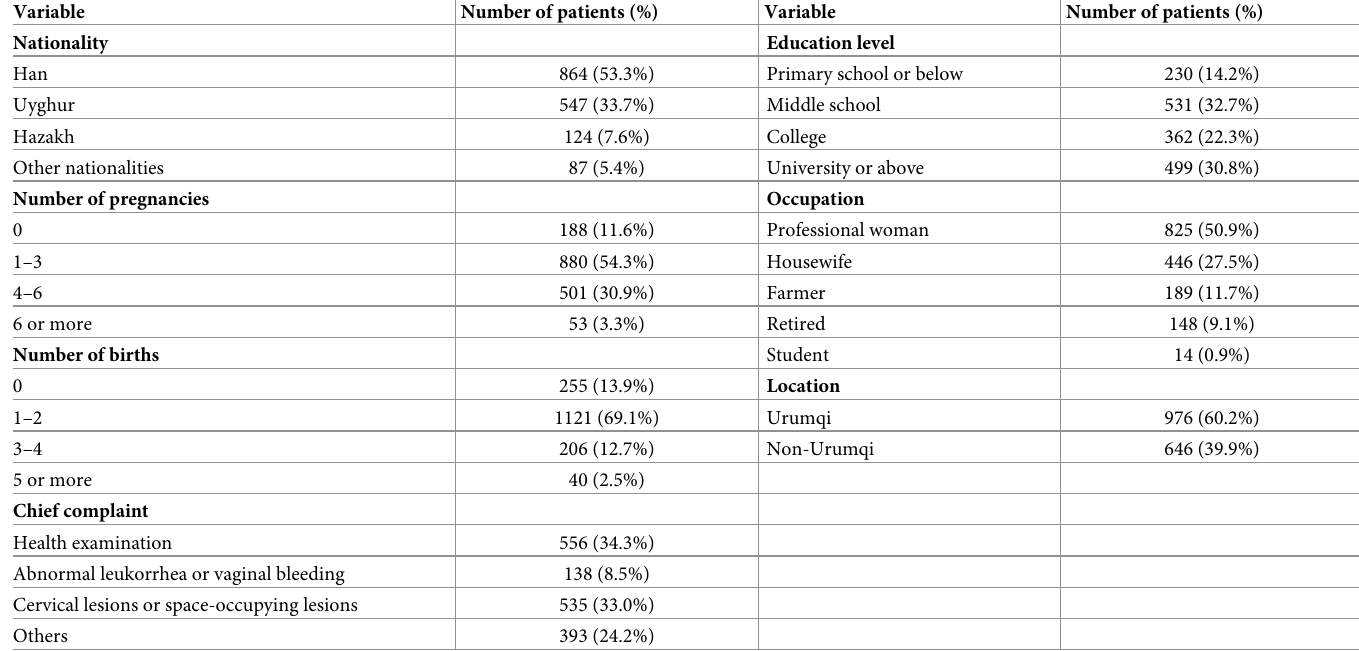
Table 1. Baseline information of the